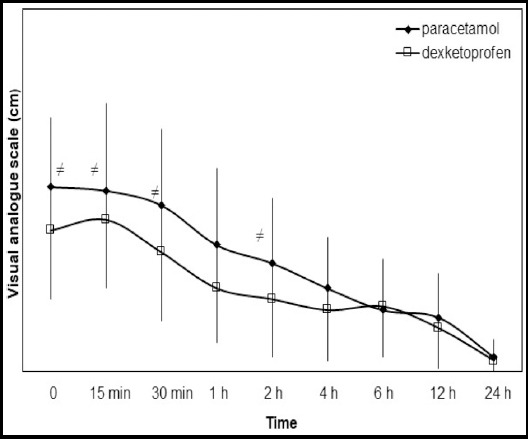
Visual analogue scale scores in the two groups at the indicated time intervals during the first 24h postoperatively. Values are presented as mean ± standard deviation. *p<0.05